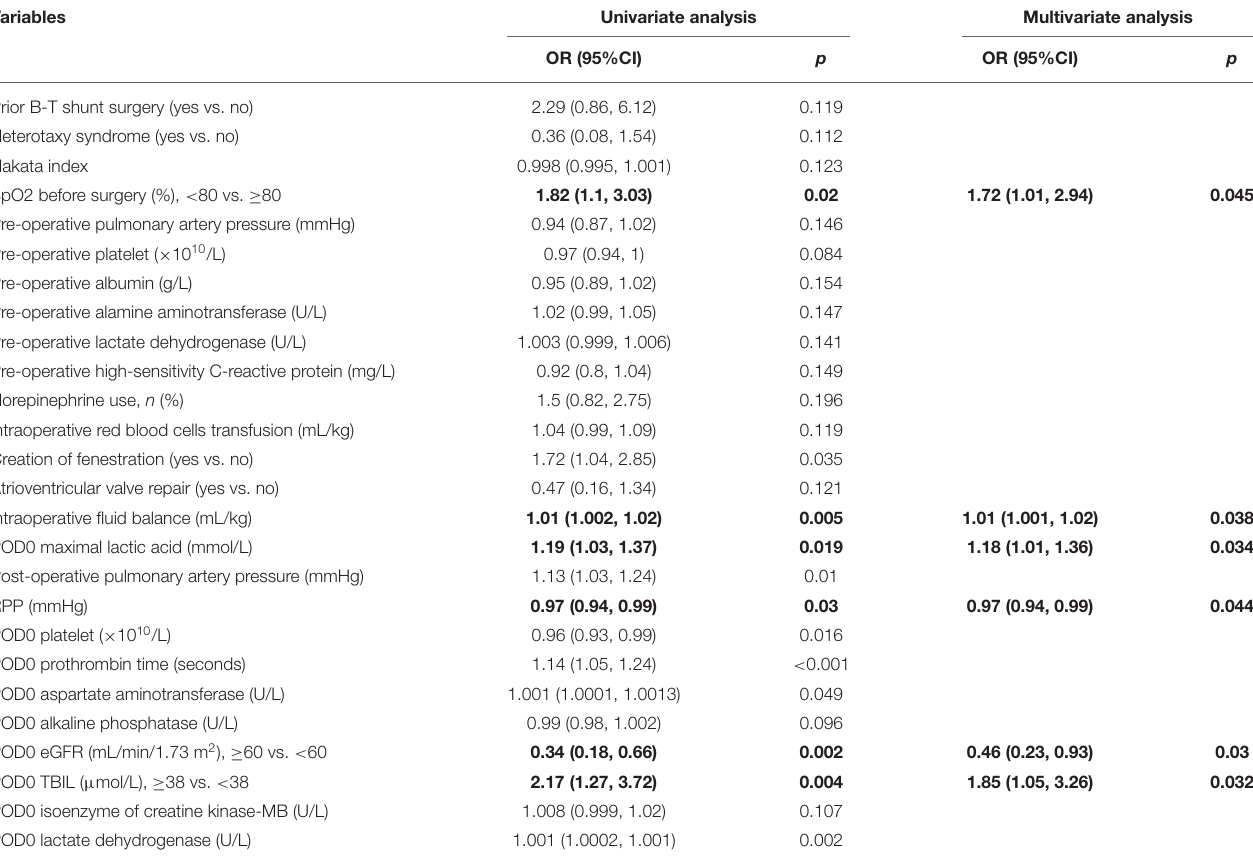
TABLE 4 | Univariate and multivariate logistic analysis odds ratios for persistent acute kidney injury.